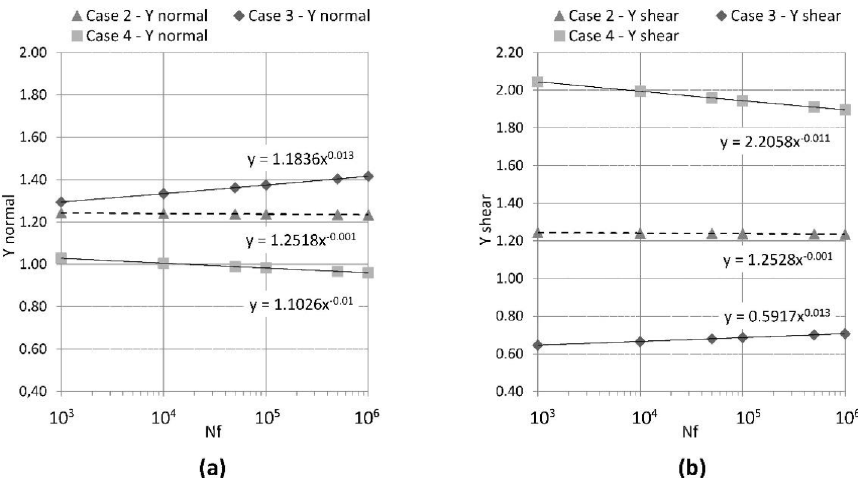
Figure 5. Y parameter evolution regarding fatigue life. ( a ) Y evaluated for the normal component, ( b ) Y evaluation for the shear